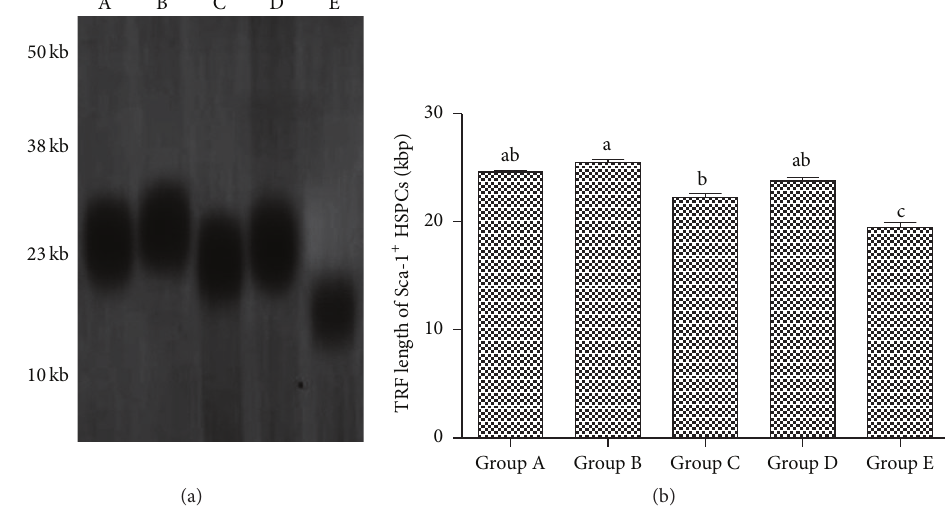
Figure 9: Telomere length of Sca-1 + HSPCs. (a) Result of Southern blotting. A: Group A (3-4-week-old mice, 13–16 g in body weight), B: Group B (8-9-week-old mice, 20–25 g in body weight), C: Group C (6-month-old mice, 35–40 g in body weight), D: Group D (12-month-old mice, 39–43 g in body weight), and E: Group E (18-month-old mice, 37–45 g in body weight). (b) Telomere length. (a–c) represent a significant difference of these columns ( 𝑃 < 0.05